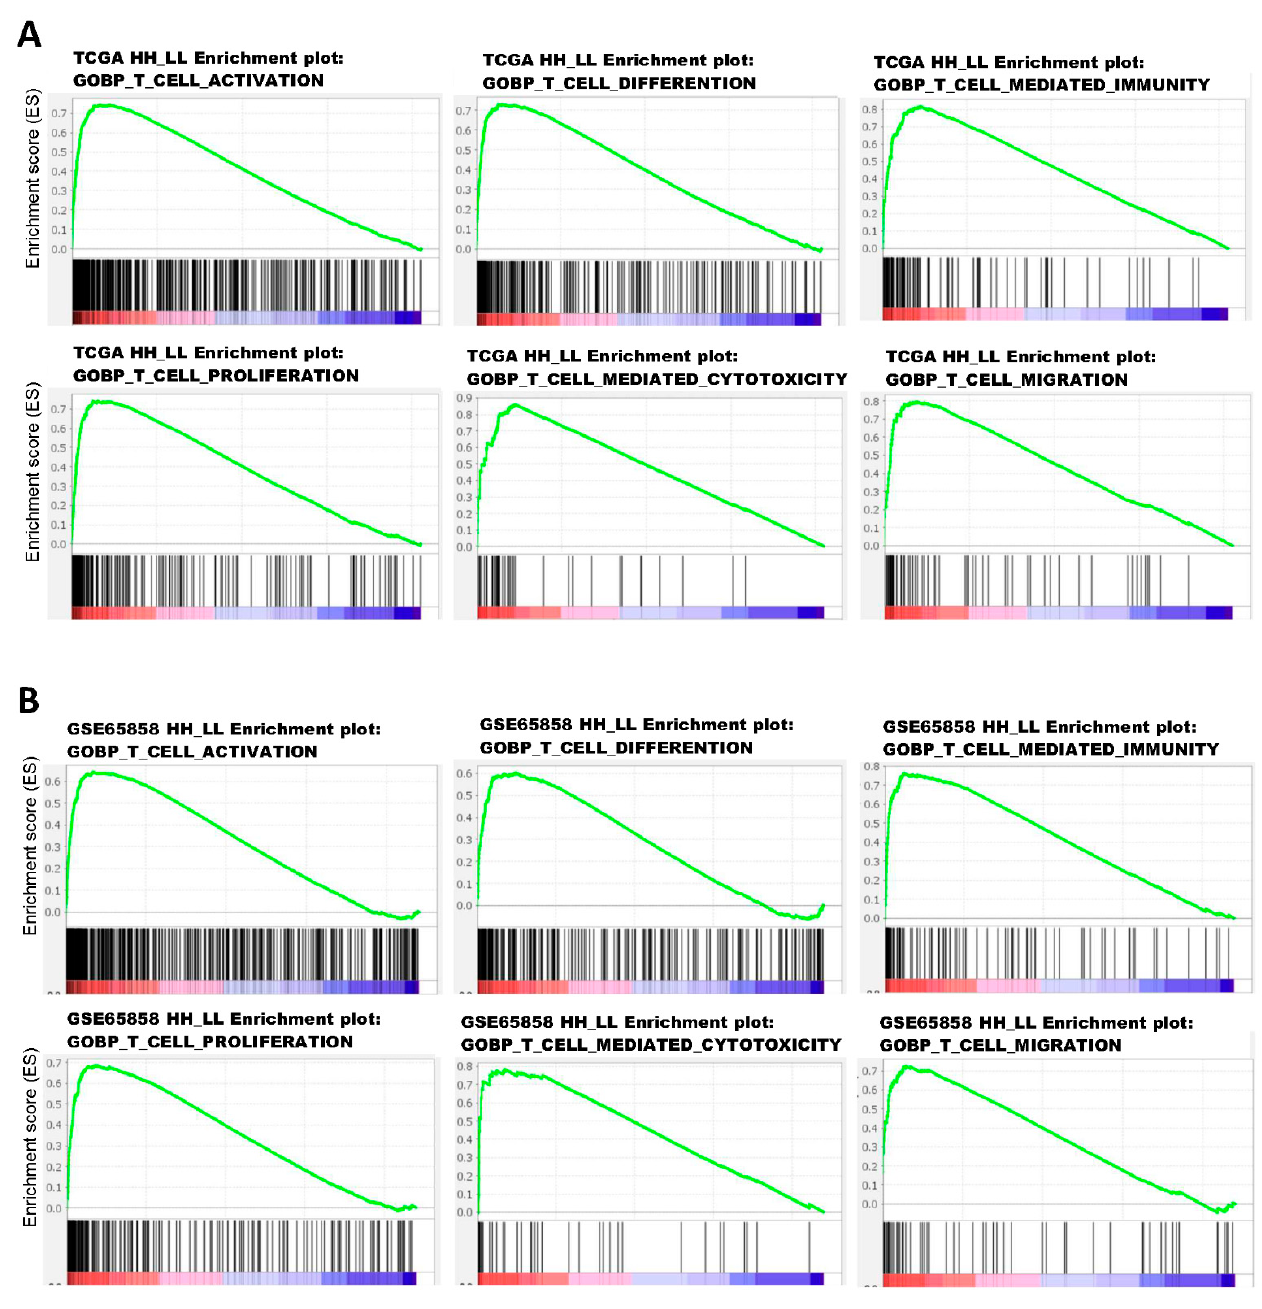
Figure 6. Enrichment plots of GOBP T-cell pathways in TCGA ( A ) and GSE65858 ( B ) oral cancer data sets based on the coordinated expression of CXCL10 and STAT2 (HH vs. LL). The case numbers of HH vs. LL used for GSEA were 108 vs. 144 for TCGA and 34 vs. 22 for GSE65858. GOBP, Gene Ontology Biological Process.